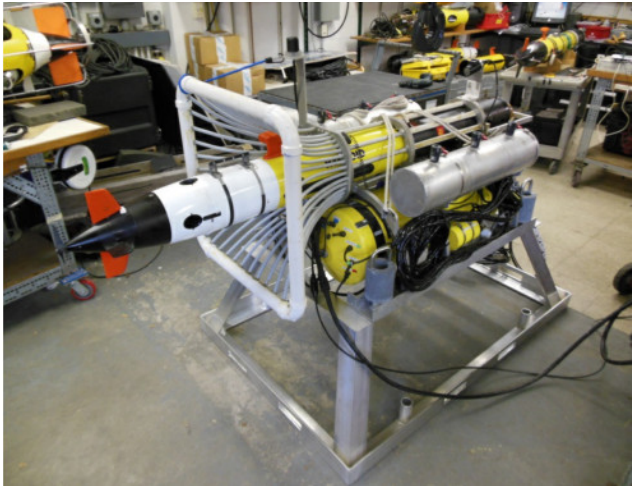
Figure 5. REMUS docking station.